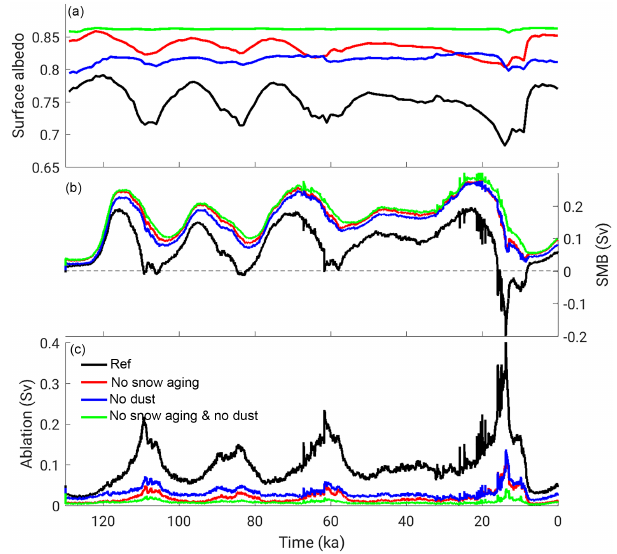
Figure 4. Results from the offline simulations. (a) Mean surface albedo over the area covered by NH ice sheets, (b) total surface mass balance and (c) total ablation for the experiments indicated in the